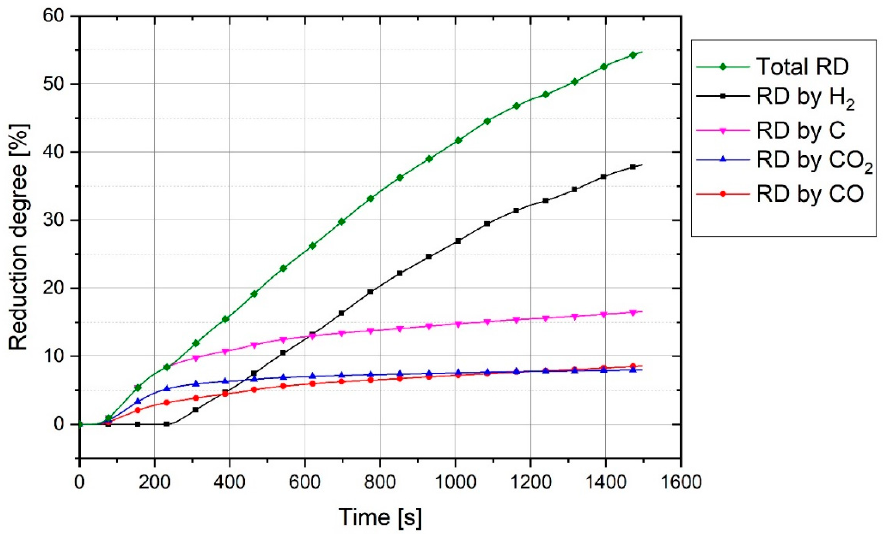
Figure 10. Degree of reduction by the production of CO, CO 2 and H 2 O and total degree of reduction of Experiment 1.